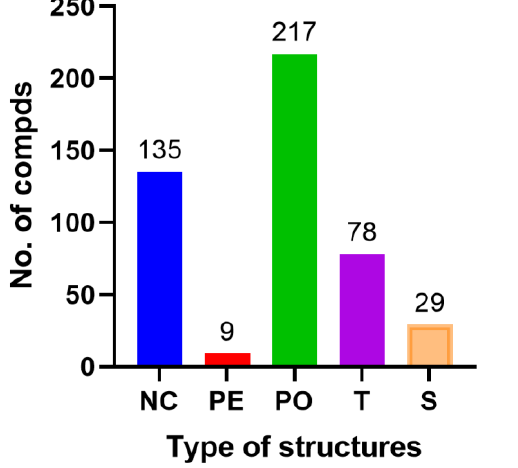
Figure 19. Different classes of metabolites reported in this review.